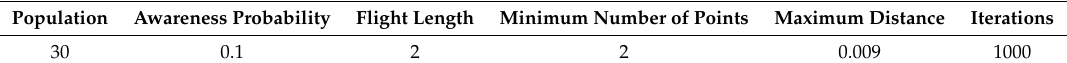
Table 5. CSA Parameters for SCP and KP—DBscan.